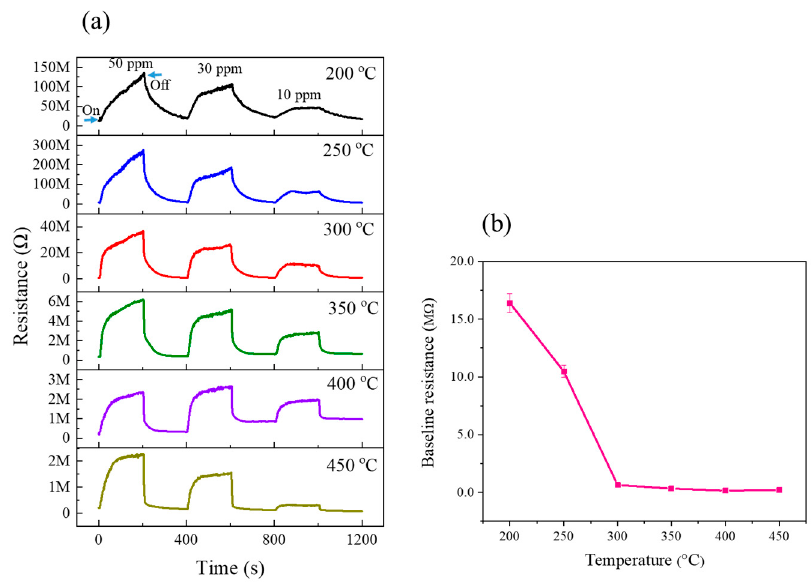
Figure 9. ( a ) Dynamic resistance curves of Au-decorated ZnO-PANI (25 wt.%) composite nanofiber gas sensor to 10, 30, and 50 ppm NO 2 gas (200–450 °C); ( b ) Baseline resistance vs. temperature.